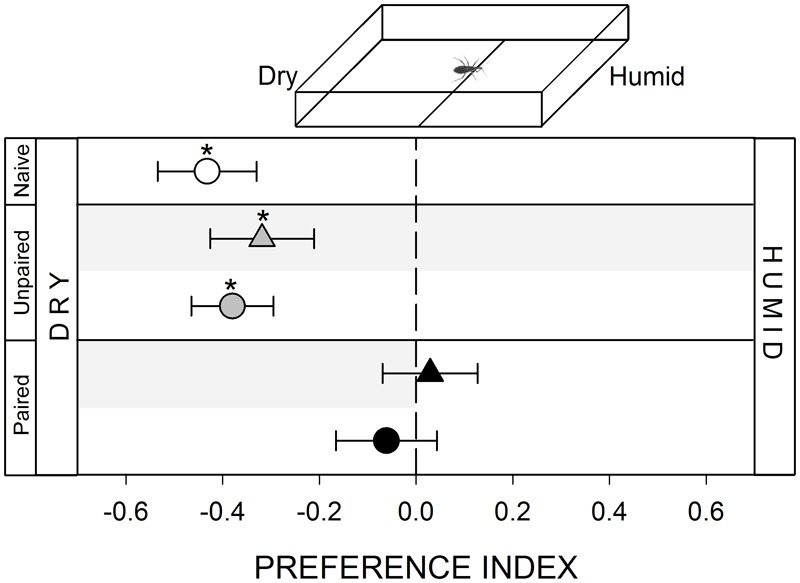
Responses of R. prolixus to a hygric stimulus. Insects innately avoided the humid zone of the arena (white circle, p < 0.05). Unpaired yoke controls presented the same pattern: i.e., hygric avoidance (gray triangle and circle, p < 0.05 in both cases). However, this avoidance disappeared during (black triangle, p < 0.05) and after (black circle, p > 0.05) training, evincing a partial modulation of this avoidance. Each point represents the mean (±SE) spatial preference of 30 insects individually released in a 2-choice rectangular walking arena. Asterisks denote statistical differences between the PI and the value 0 (p < 0.05) evinced by One sample T-test. Gray shadows show the zone in which punishment was delivered during unpaired and paired trainings.